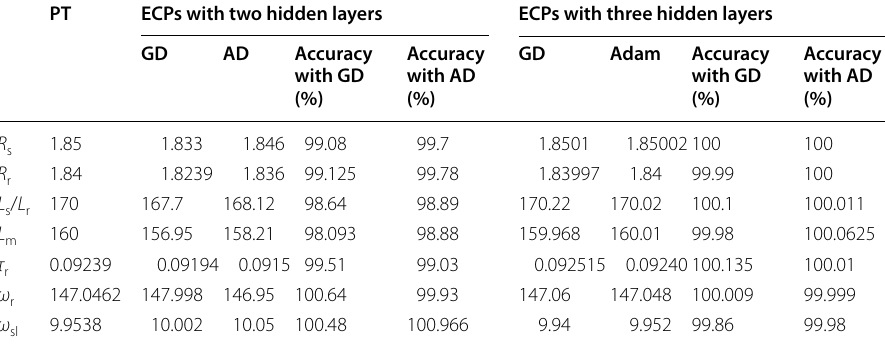
Table 2 ECPs evaluation using 2 and 3 hidden layers PT ECPs with two hidden layers ECPs with three hidden